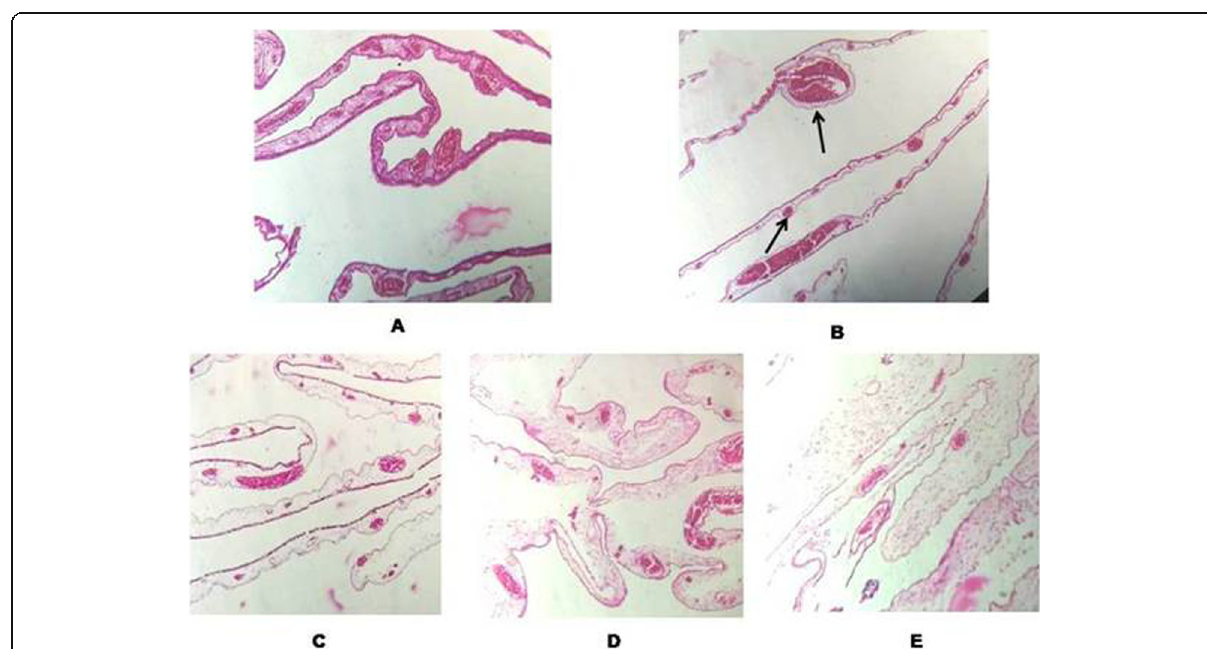
Fig. 11 Histopathological examination of chick embryos at × 40 magnification. a Control CAM. b DMSO treated control. c 0.5 mg/mL treated. d 1 mg/mL treated. e 2 mg/mL treated. Black arrow indicates the presence of large and small blood